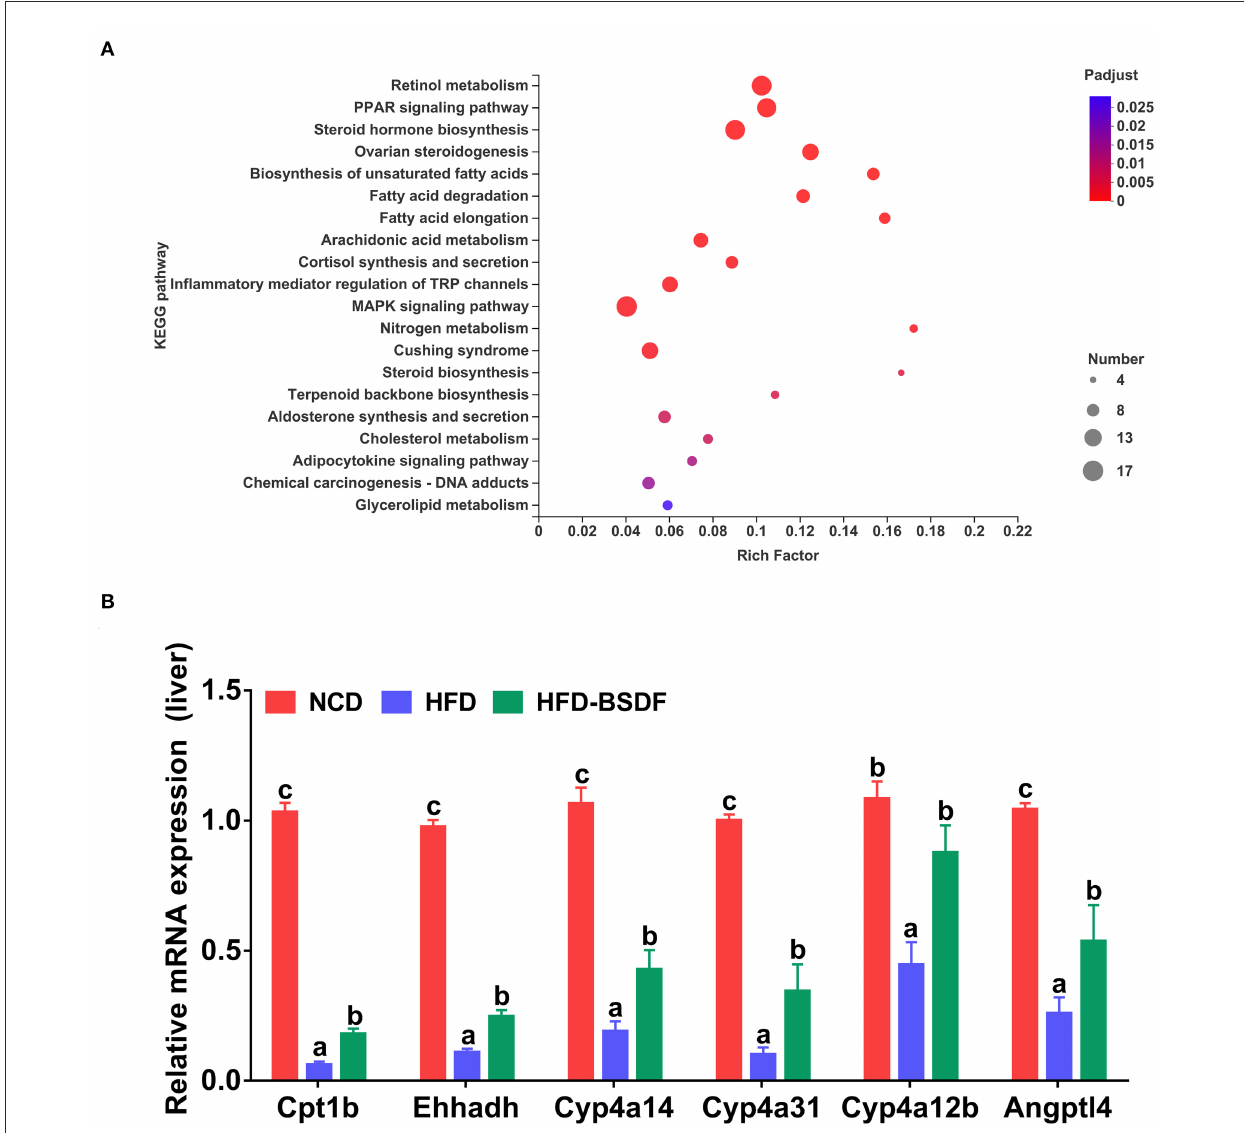
FIGURE3 Effects of BSDF administration on the liver transcriptome in HFD-induced obese mice. (A) Kyoto Encyclopedia of Genes and Genomes (KEGG) pathway analysis using DEGs between t the NCD, HFD, and HFD-BSDF groups. n = 5 per group. (B) Relative mRNA expression of important genes on the PPAR signaling pathway in liver. n = 8 per group. Data presented as mean ± SEM, n = 8 . a, b, c means in the same bar without a common letter differ at p < 0.05. NCD, normal control diet; HFD, high-fat diet; HFD-BSDF, high-fat diet supplemented with 6% BSDF freeze-dried